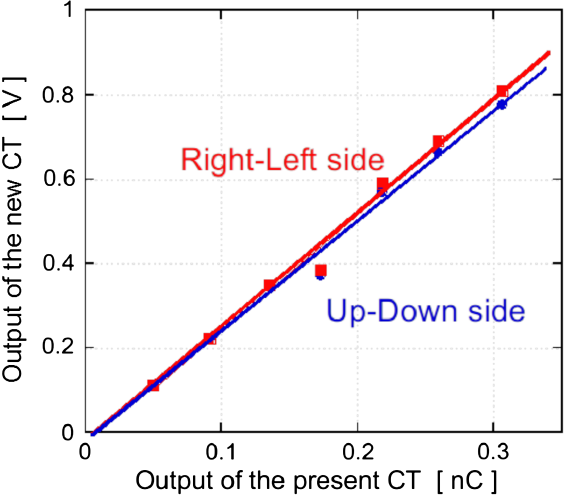
FIG. 15. Calibration of the DCT charge sensitivity. The output voltage was measured, while the charge amount of the electron beam was changed. This charge amount was measured with the CT made by Bergoz, which was calibrated with a Faraday cup. The red squares (right-left) show the subtracted data of the horizontal two ports and the blue circle (up-down) is the sub- tracted data of the vertical two-ports.